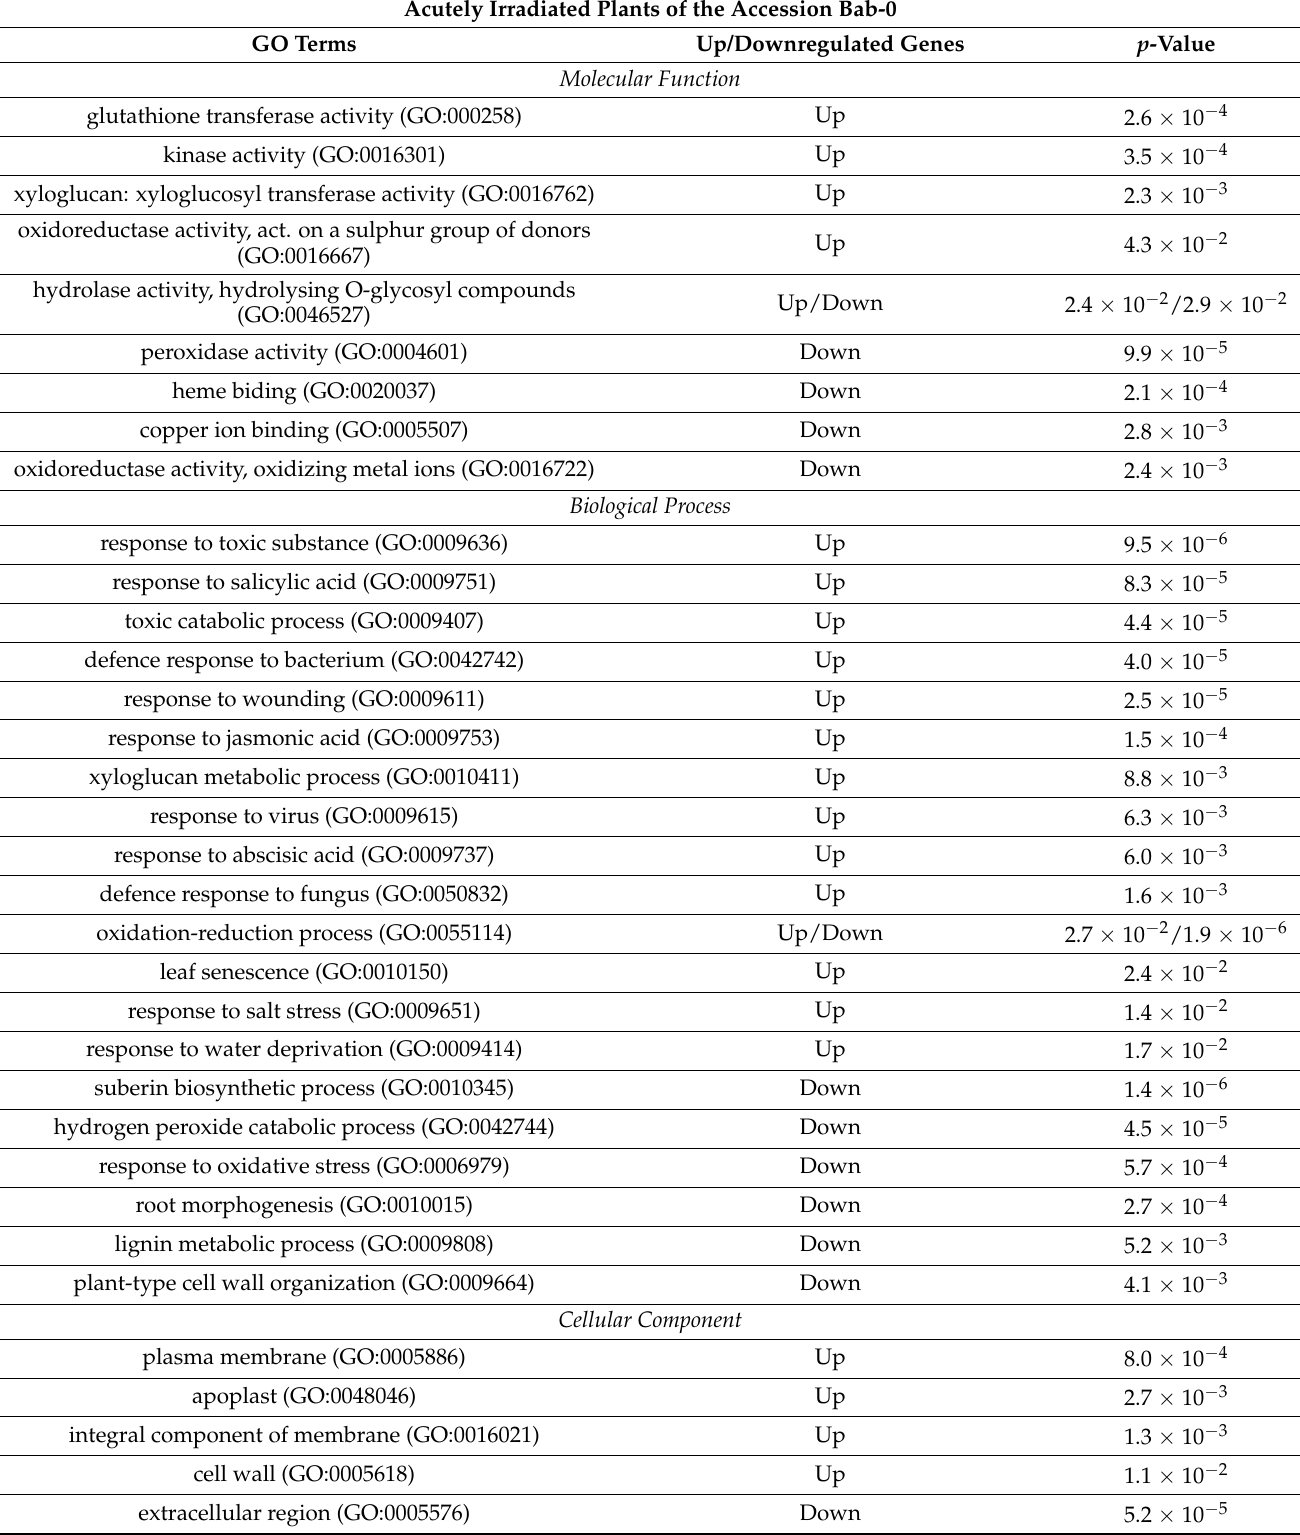
Table 4. The selected enriched GO terms for the seedlings of acutely irradiated seeds in comparison with seeds of the same accession without additional